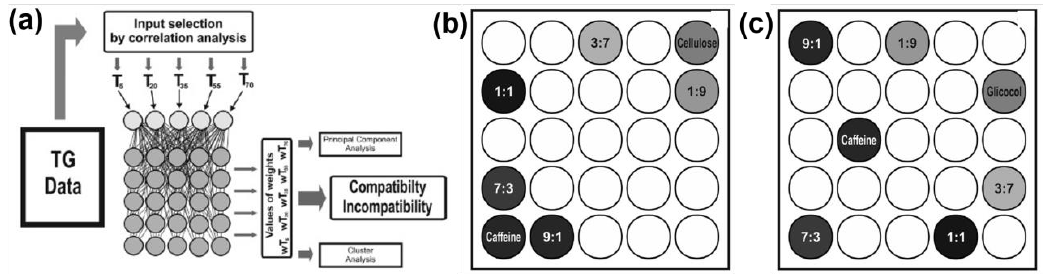
Figure 9. ANN application in the compatibility assessment [89]: ( a ) Schematic of the proposed workflow and mapping with ANN of caffeine mixtures with cellulose ( b ) and glycine ( c ), mixture ratios are indicated, i.e., 9:1, 7:3, 1:1, 3:7, 1:9. Reprinted with permission from Elsevier.